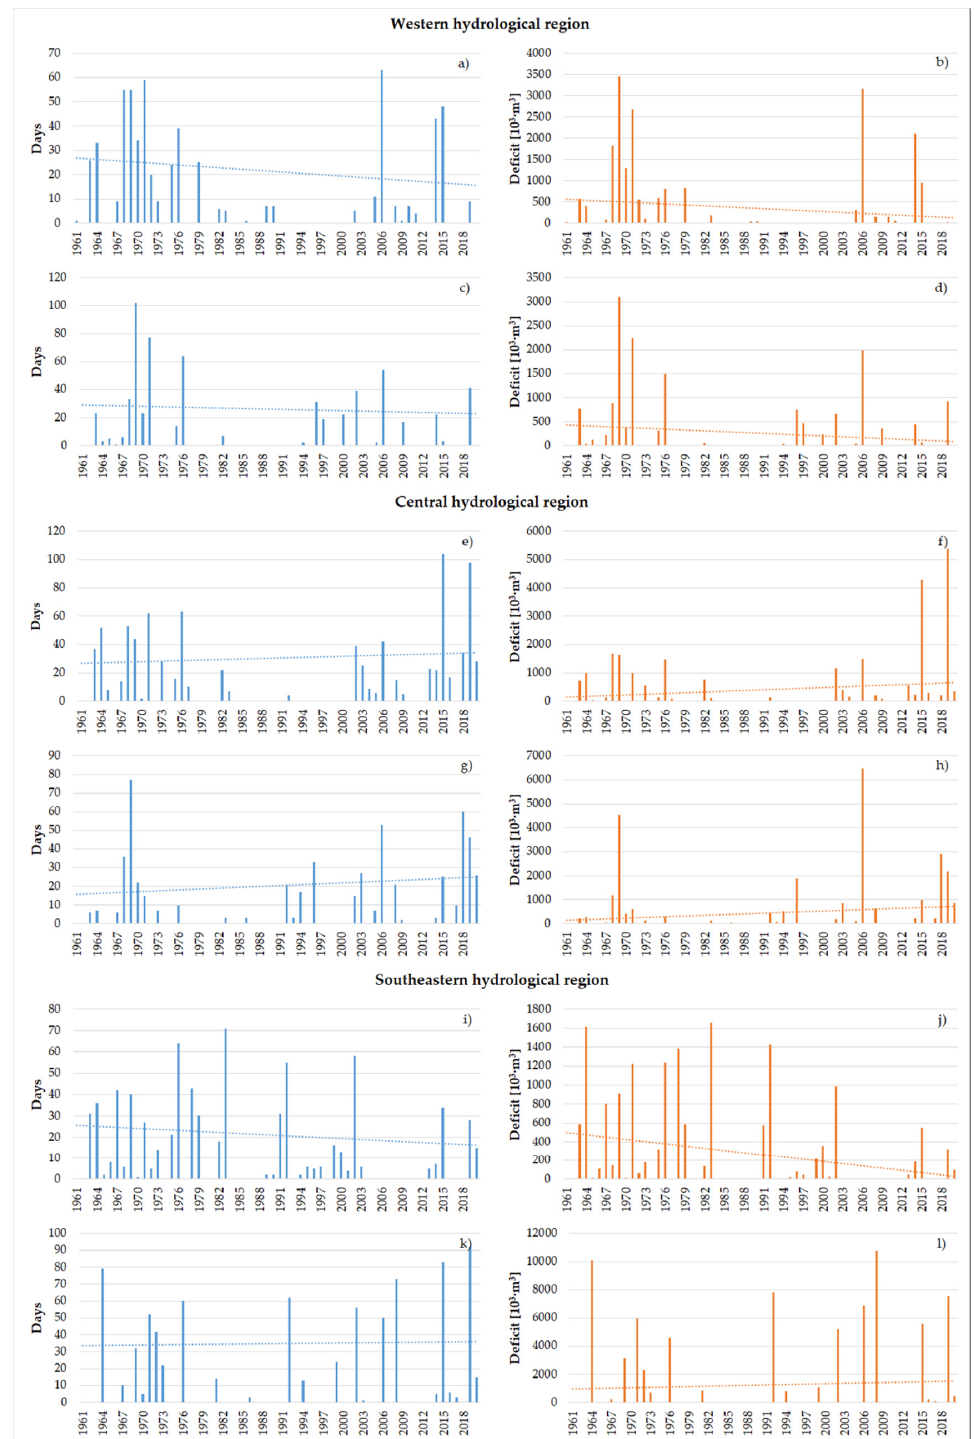
Figure 12. Examples of drought changes for 30Q80 threshold over time: ( a ) days with drought in JUR river, ( b ) deficit volume in JUR river, ( c ) days with drought in MIN river, ( d ) deficit volume in MIN river, ( e ) days with drought in SES river, ( f ) deficit volume in SES river, ( g ) days with drought in VEN2 river, ( h ) deficit volume in VEN2 river, ( i ) days with drought in VER river, ( j ) deficit volume in VER river, ( k ) days with drought in ZEI river, ( l ) deficit volume in ZEI river.